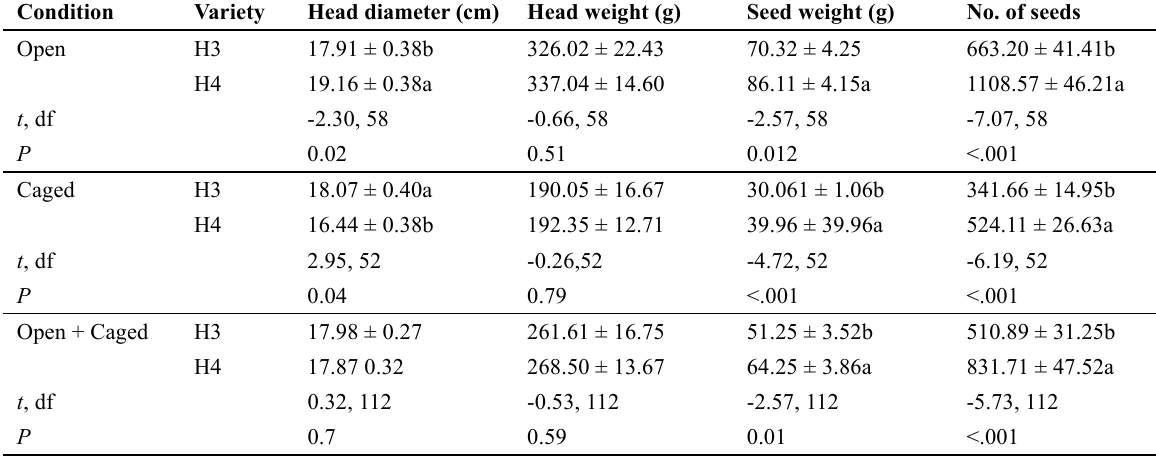
Table 5 . Mean (± SE) head diameter, head weight, seed weight, and number of seeds recorded for two sunflower cultivars under the open, caged and combined (open + caged)